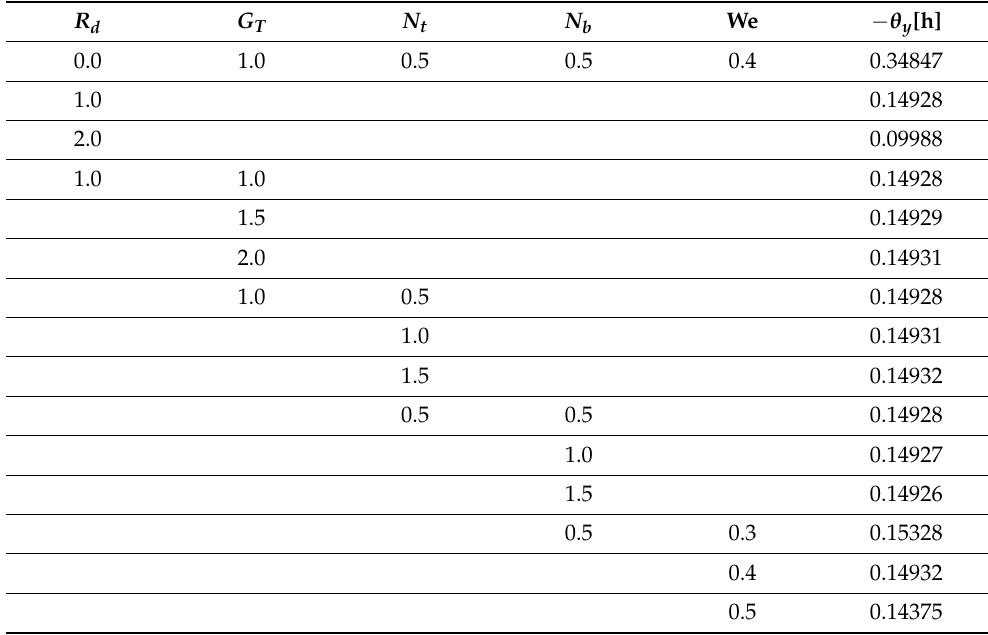
Table 1. Effect of embedded parameters on the heat-transport